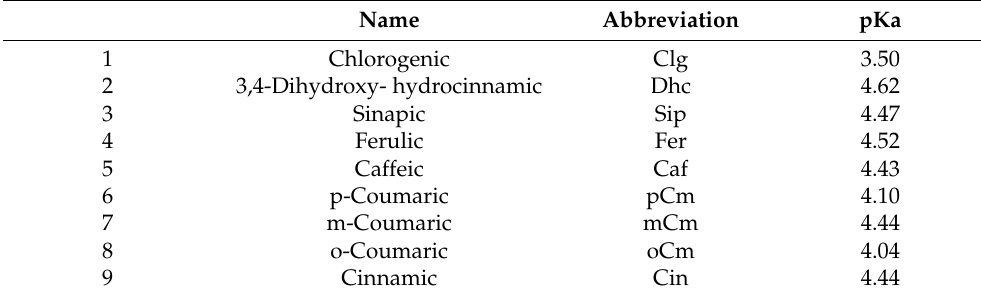
Table 1. List of cinnamic acid derivatives with their corresponding acid dissociation constant pKa.